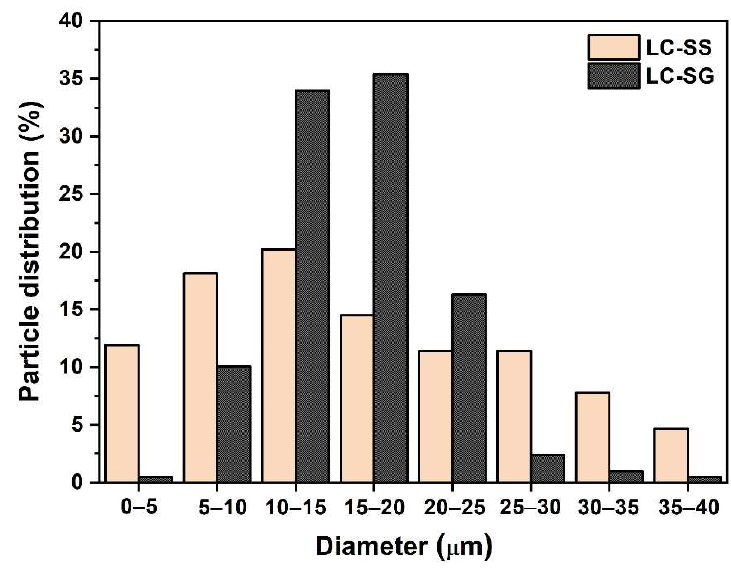
Figure 10. Particle size distribution of the LC spherical particles.